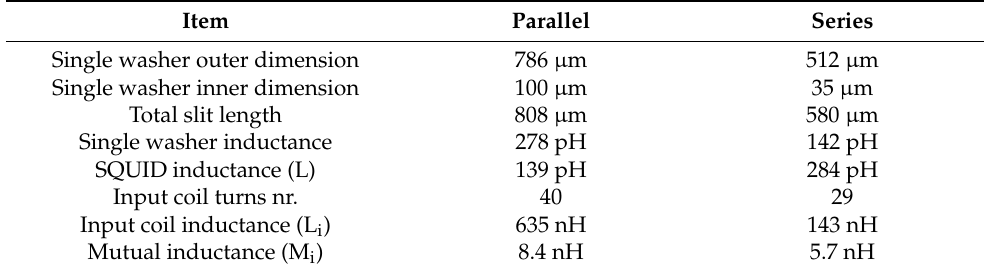
Table 1. Main geometrical and electrical parameters of current sensor devices. Item Parallel Series Single washer outer dimension 786 µ m 512 µ m Single washer inner dimension 100 µ m Total slit length Single washer inductance 278 pH 142 pH SQUID inductance (L) 139 pH 284 pH Input coil turns